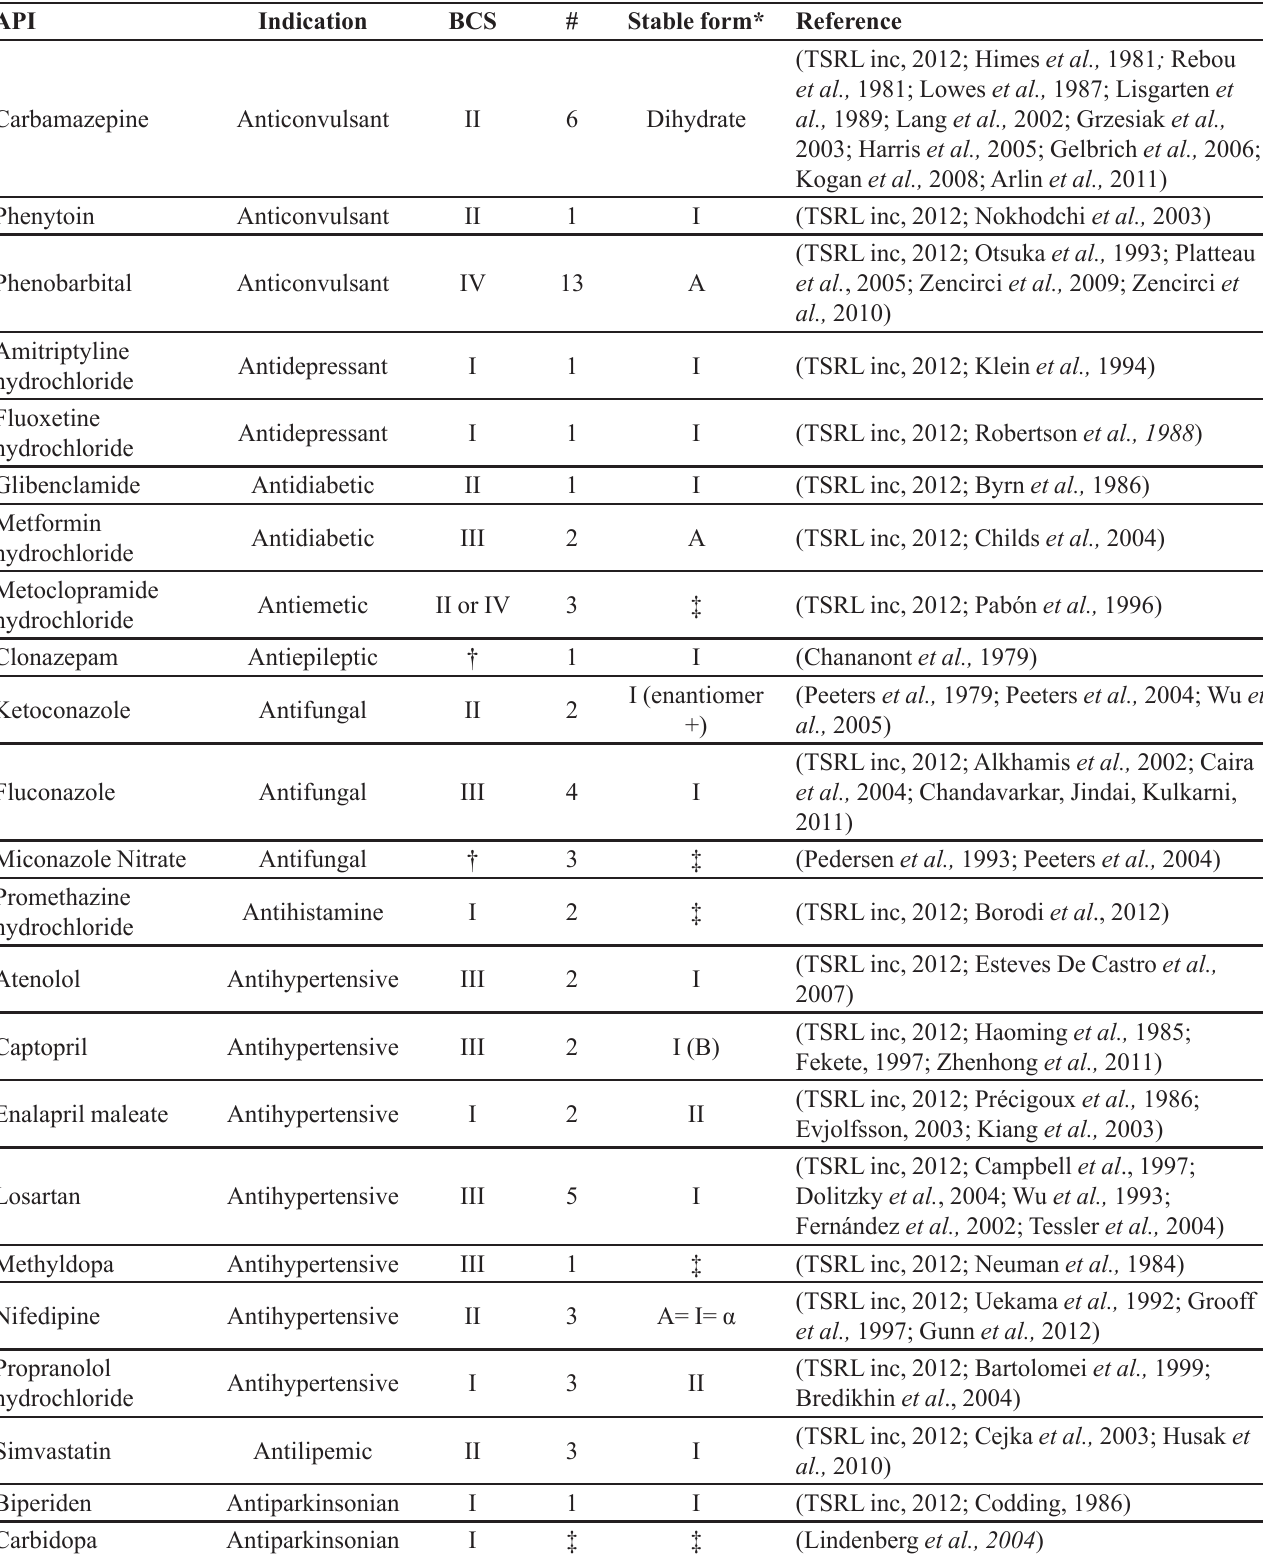
TABLE I - Solid-state forms of Farmácia Popular drugs